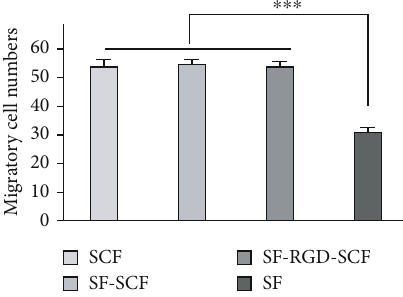
Figure 4: Migrated cell numbers (each vision fi eld) for SCF, SF-SCF, SF-RGD-SCF, and SF groups. Data are means with SD error bars ( n = 9 ). ∗∗∗ P < 0 : 001 compared with the negative control